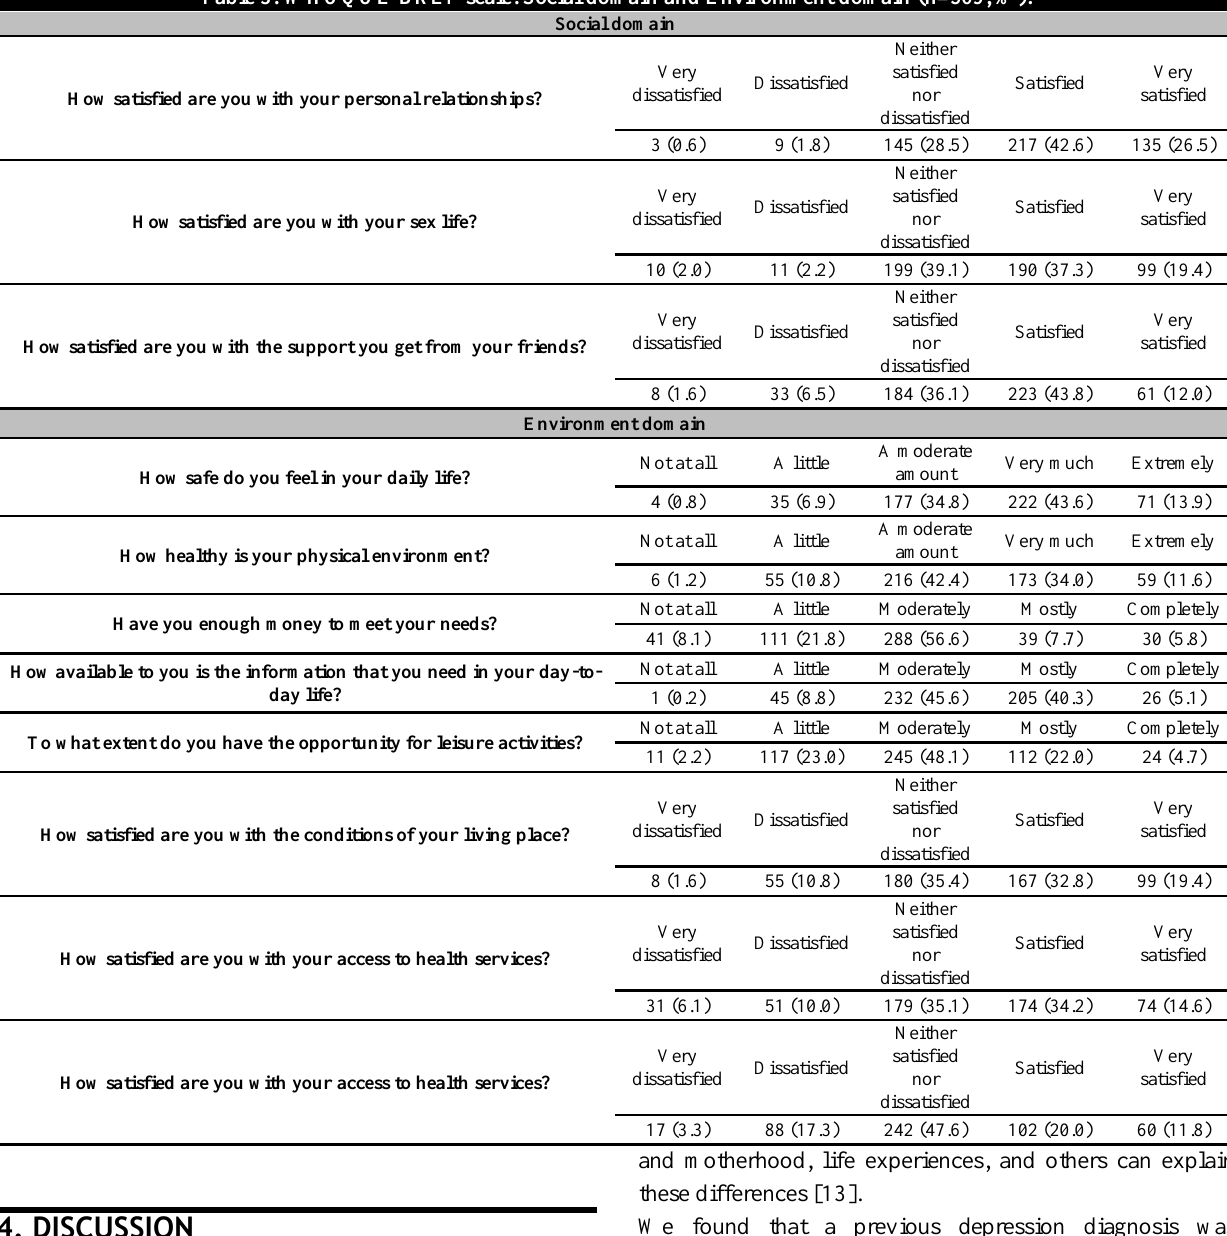
Table 3: WHOQOL-BREF scale. Social domain and Environment domain (n=509, %). Social